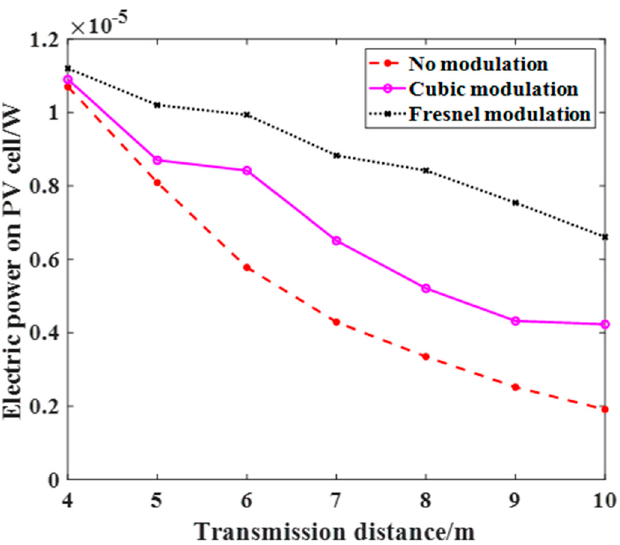
Figure 6. Voltage vs. current curve of the PV cell.